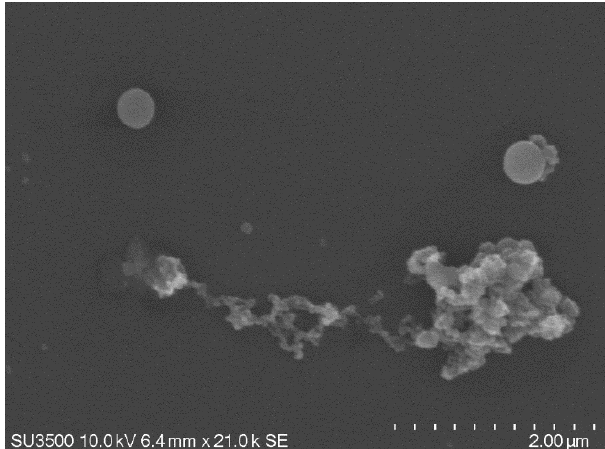
Figure 7. SEM image of aerosol collected after the thermodenuder during Fire A. While most of the particles appeared fractal-like, some spherical particles (presumably non-volatile organics) were also